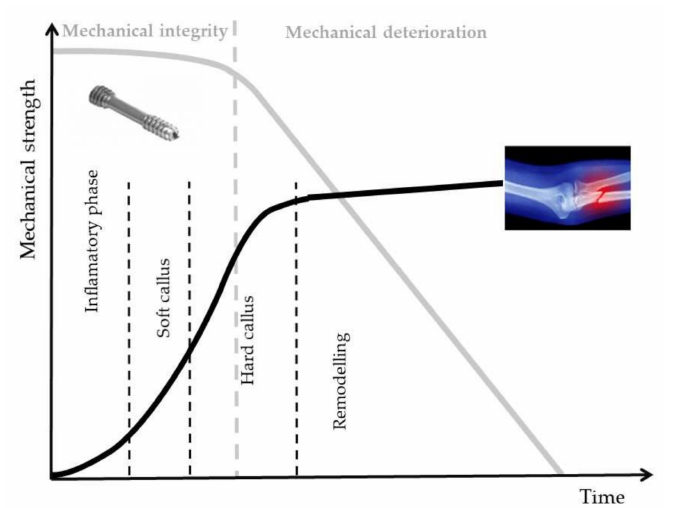
Figure 1. Degradation behavior of Mg alloy implants in bone fracture healing made in optimal conditions, adapted from